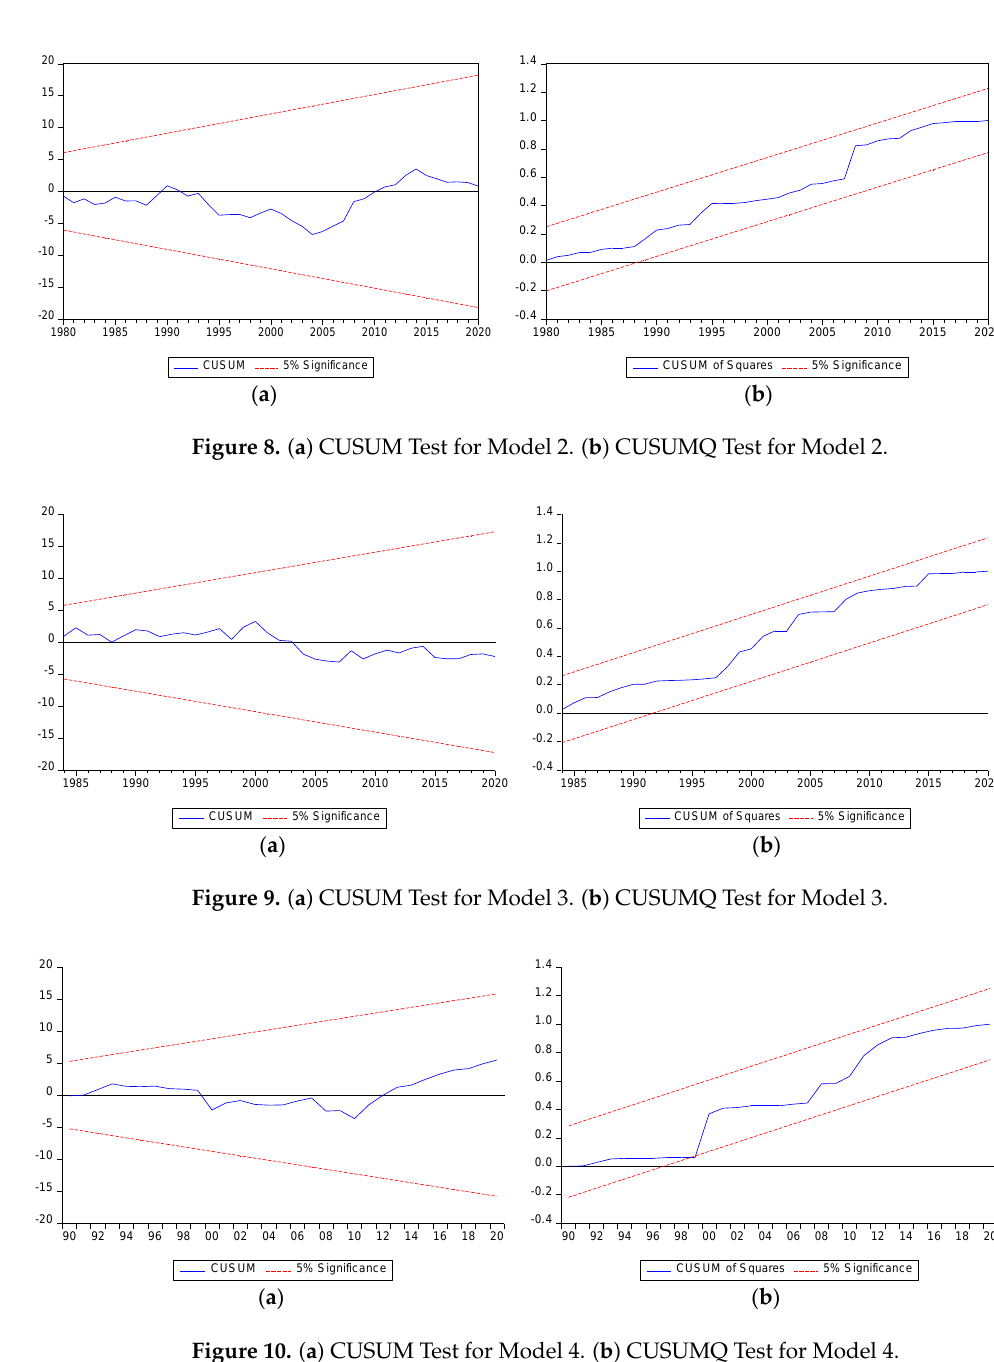
Figure 7. ( a ) CUSUM Test for Model 1. ( b ) CUSUMQ Test for Model 1.